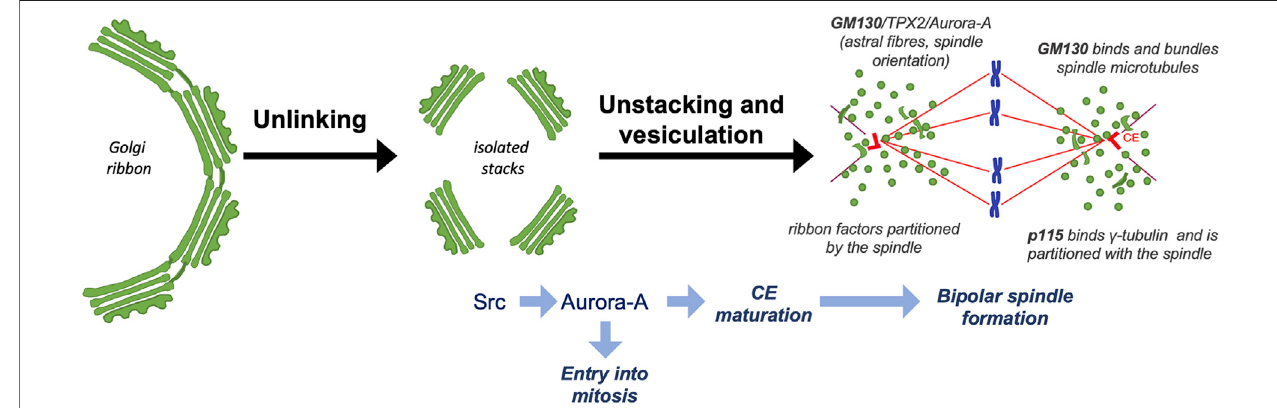
FIGURE1| Schematic description ofGCdisassembly during G2and functionalconnectionswithmitosis. During G2,the GCisunlinked intostacks, leading tothe activationofaSrc/Aurora-Asignalingaxisthatdrivescentrosomematurationandentryintomitosis.Aftermitosisonset,theGolgistacksaredisassembledintodispersed vesicles and clusters. Golgi-associated proteins, including GM130 and p115, are repurposed to form a bipolar, symmetric and correctly oriented spindle that mediates the inheritance of proteins necessary for GC ribbon reformation at mitotic exit.